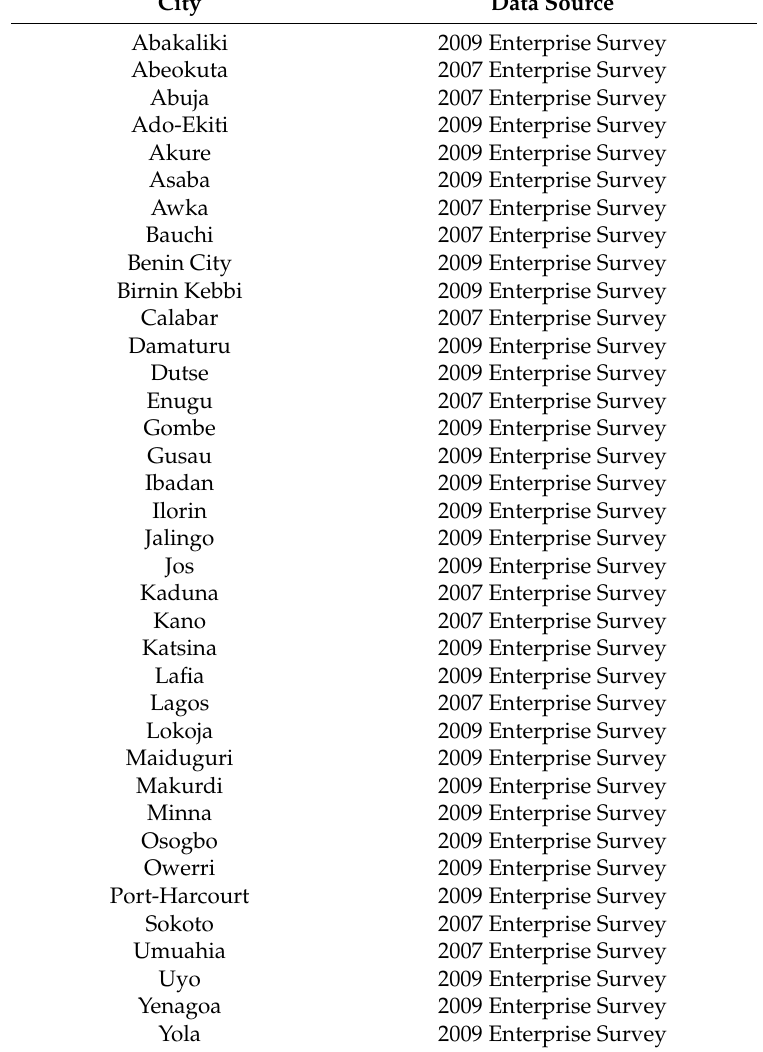
Table 1. City Infrastructure Quality Index (CIQI) Cities and Data